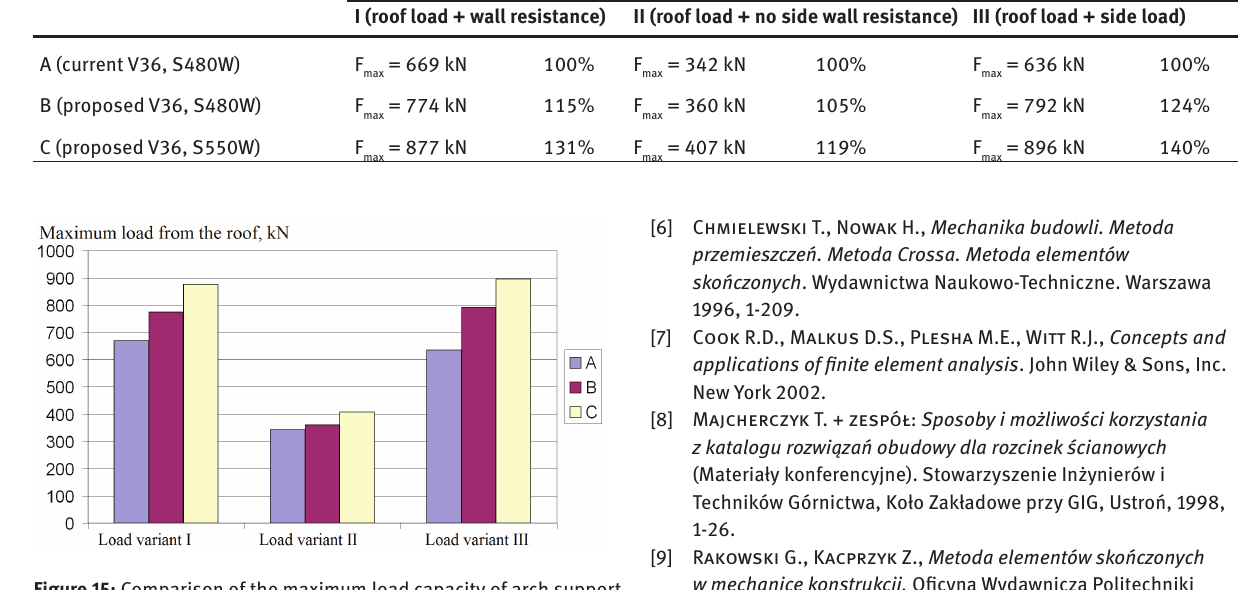
Figure 15: Comparison of the maximum load capacity of arch support A, B and C for different load